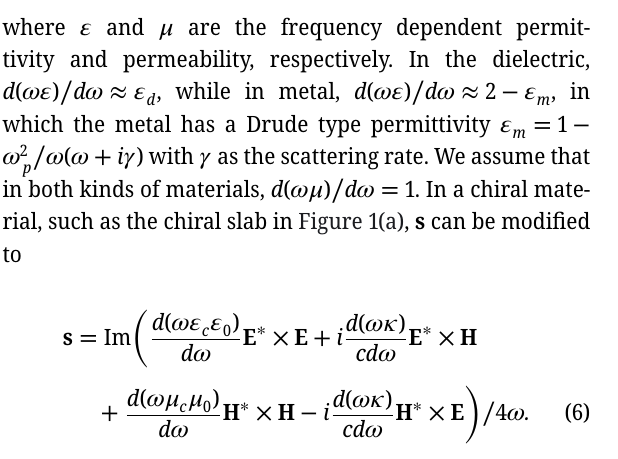
Figure 4: The normalized spin AM densities of the symmetric (a) and antisymmetric modes (b) along three directions. The parameters are the same as Figure